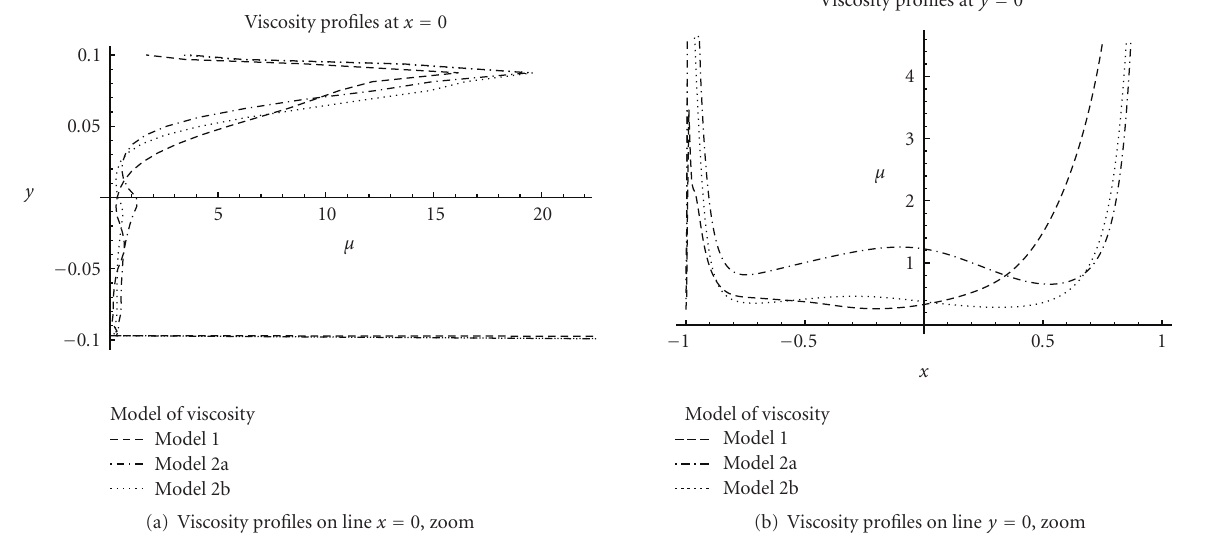
Figure 10: Comparison of viscosity profiles on y - and x -cuts.